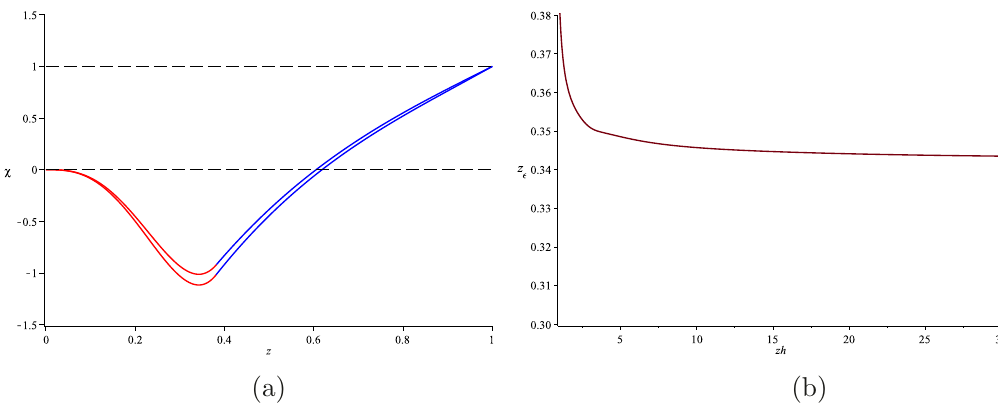
Figure 5 . (a) The smoothly matching solution for µ = 0 (top) and µ = 1 (down) at horizon z H = 1. The red branches represent asymptotic solutions χ B near the boundary z = 0 and the blue branches are asymptotic solutions χ H near the horizon z = z H . The two branches are smoothly connected at the matching point z ǫ which is obtained by solving eq. (3.29). (b) The matching points vs. horizons. The matching point is saturated for large z H , i.e. the low